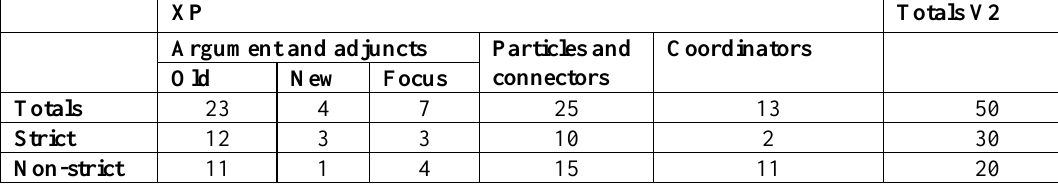
Table 3. Informational value of XPs in Queste dialogue